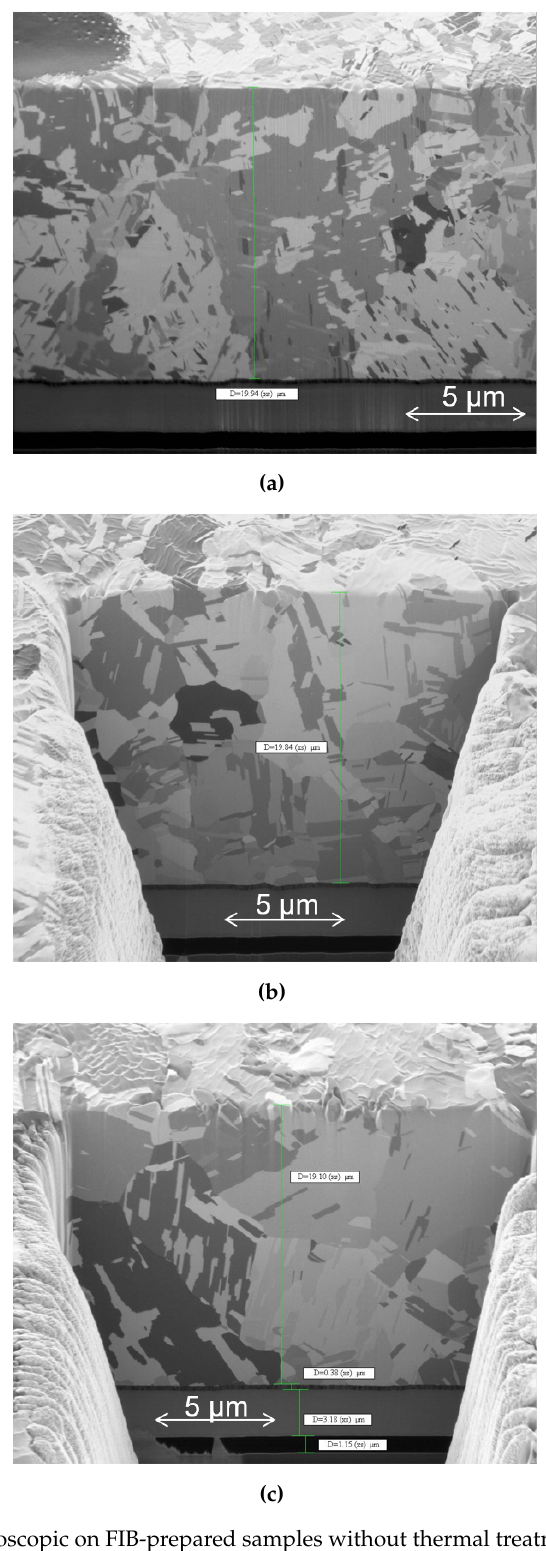
Figure 8. Scanning electron microscopic on FIB-prepared samples without thermal treatment ( a ), heated at 150°C ( b ), and at 250°C ( c ). Grains can be distinguished by grey